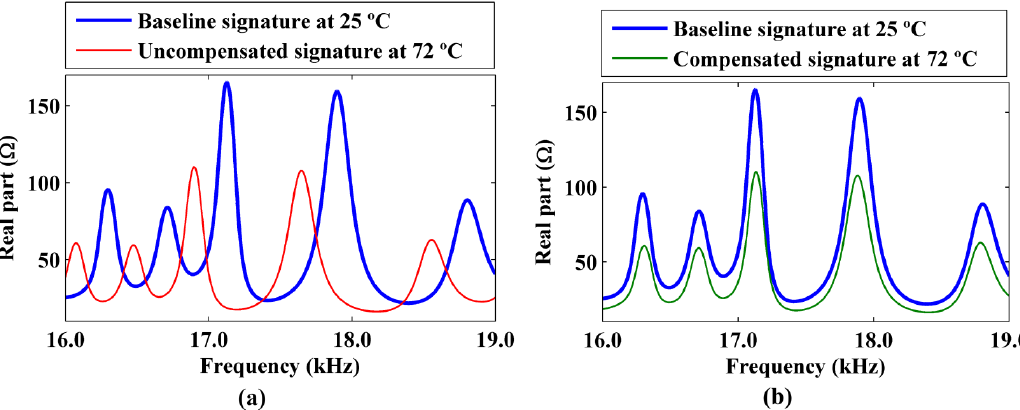
Figure 15. ( a ) Uncompensated and ( b ) compensated impedance signature obtained at 72 °C relative to the baseline signature at 25 °C using a narrow frequency band.